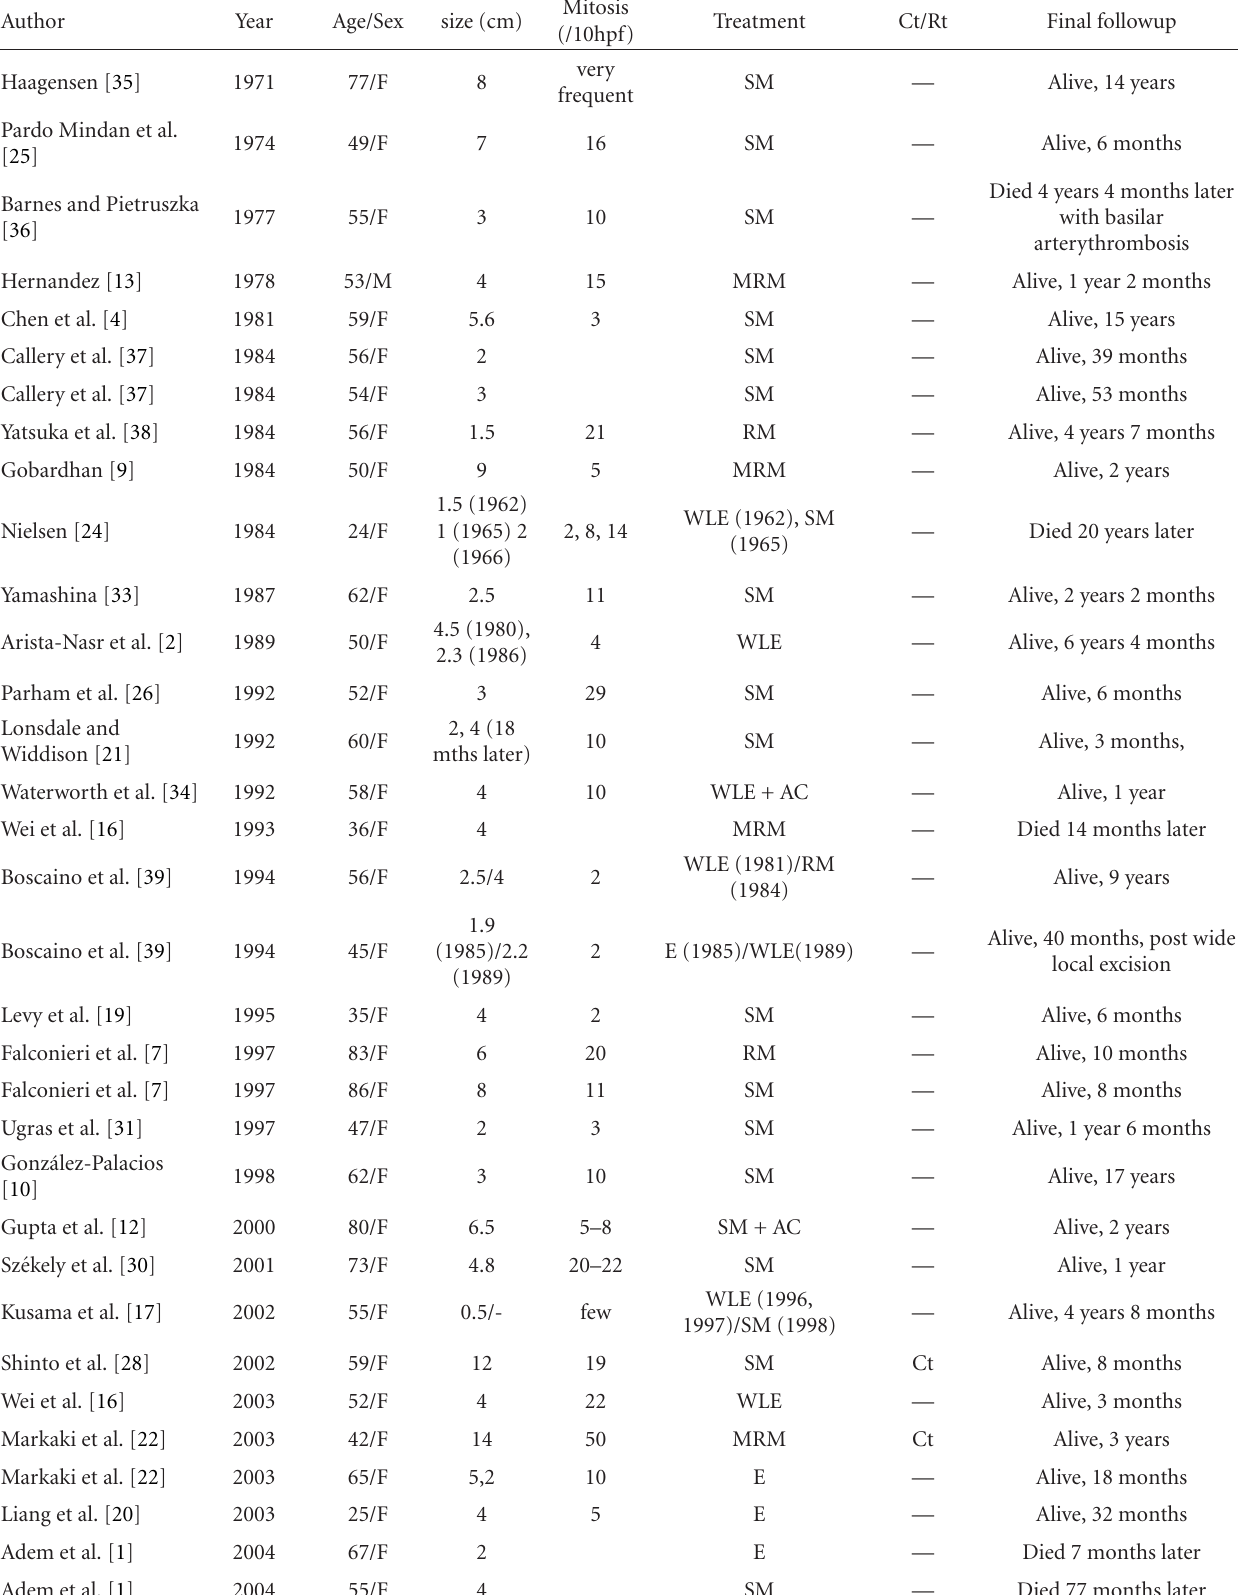
Table 1: Comparison of clinicopathological variables of all the cases of primary leiomyosarcoma of breast reported in the English literature.